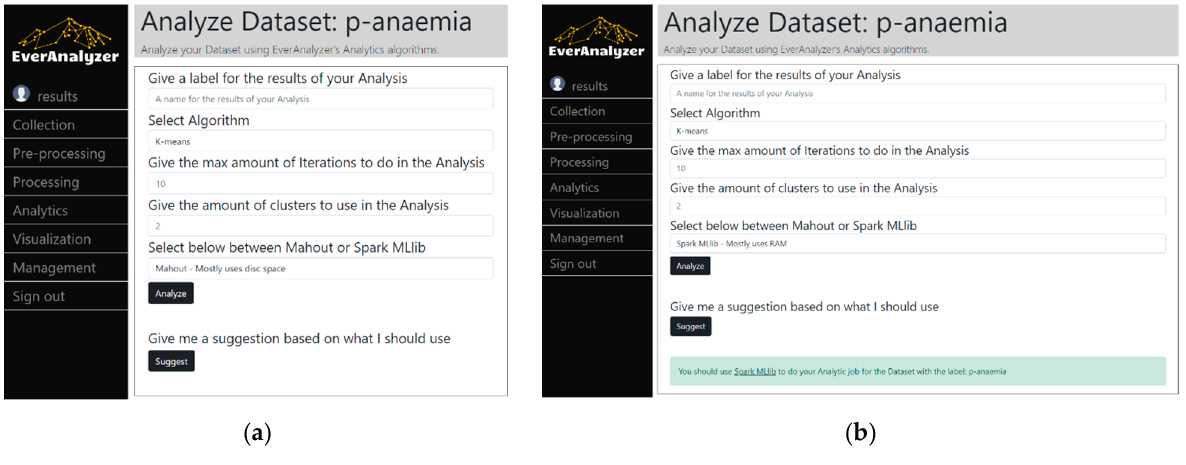
Figure 20. ( a ) Analytics form; ( b ) Analytics proposal.